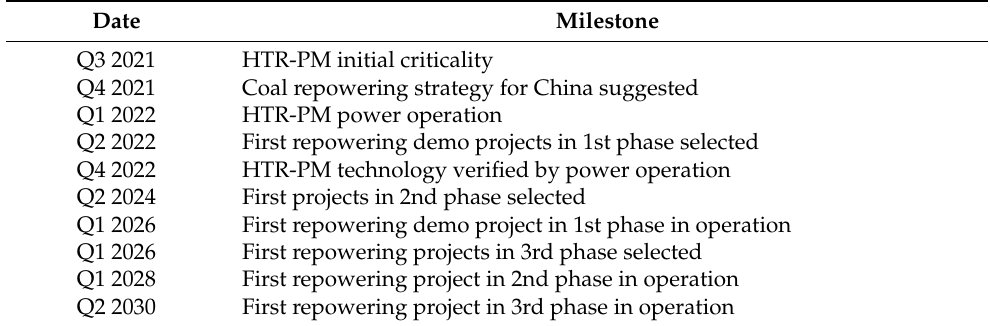
Table 2. Possible milestones of the 3-phase repowering strategy for China.